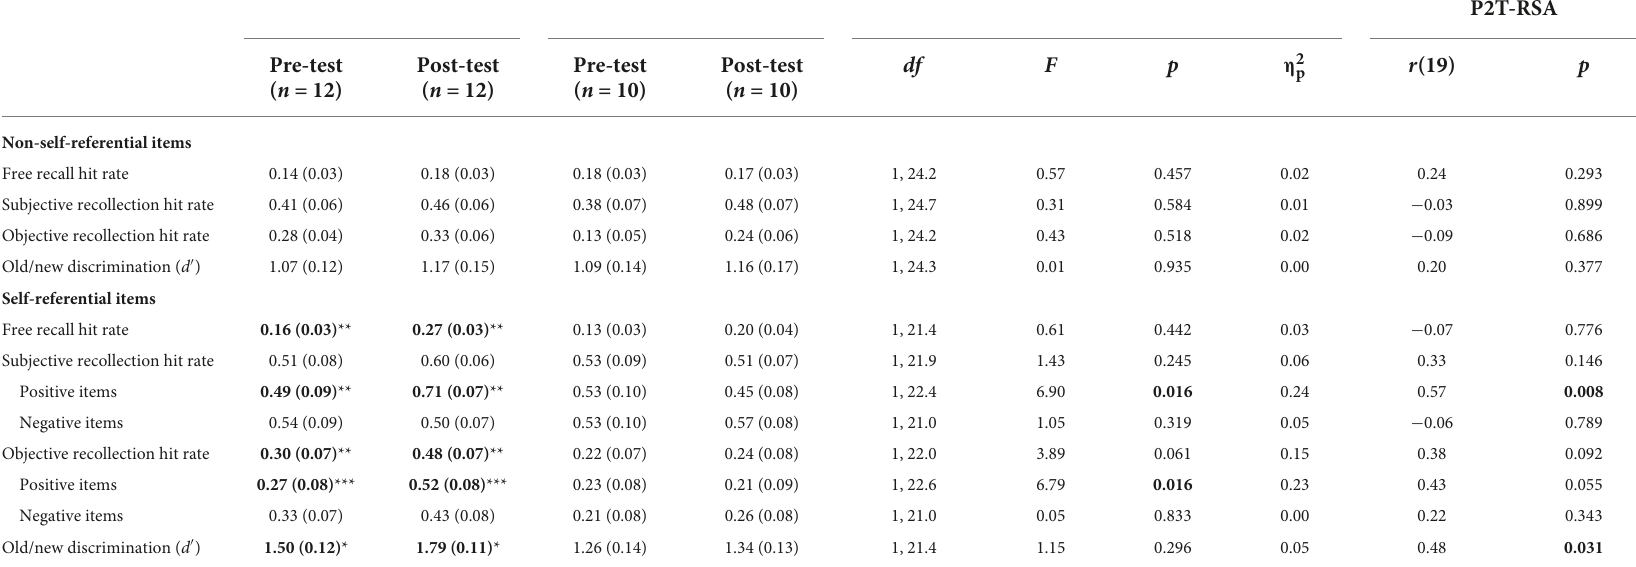
TABLE 5 Episodic memory